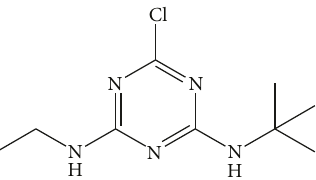
Figure 1: Chemical structure of the herbicide